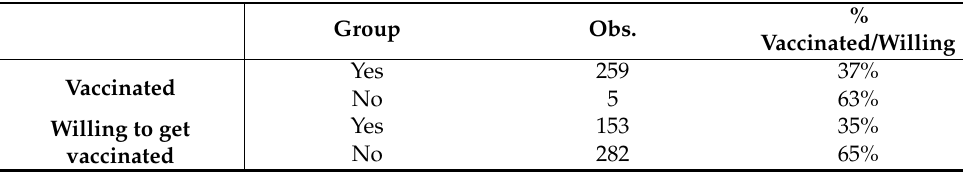
Table 1. Vaccine uptake and